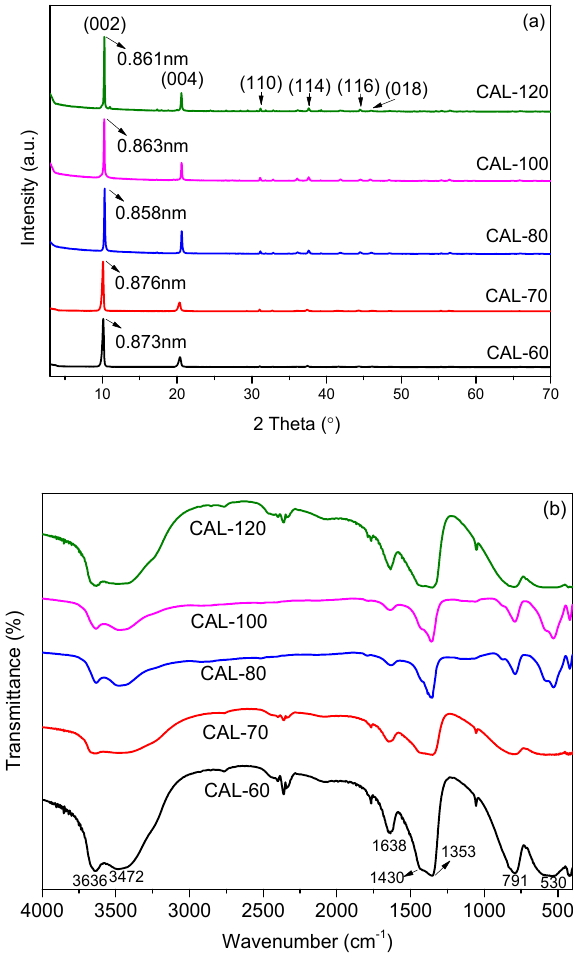
Figure 1. XRD patterns ( a ) and FT-IR spectra ( b ) of CaAl-NO 3 − layered double hydroxides (LDHs) prepared at di ff erent temperatures (samples were indicated as CAL-x, where x = aging temperature, 60–120 ◦